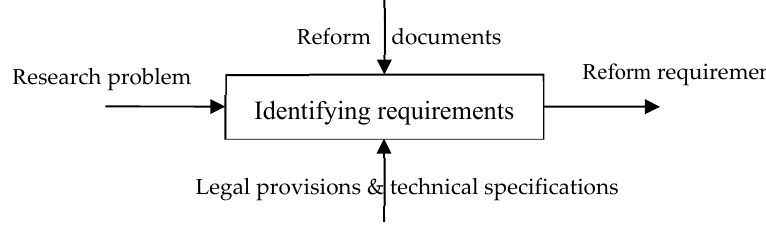
Figure 2. Inputs and output of the analysis process of identifying related requirements.